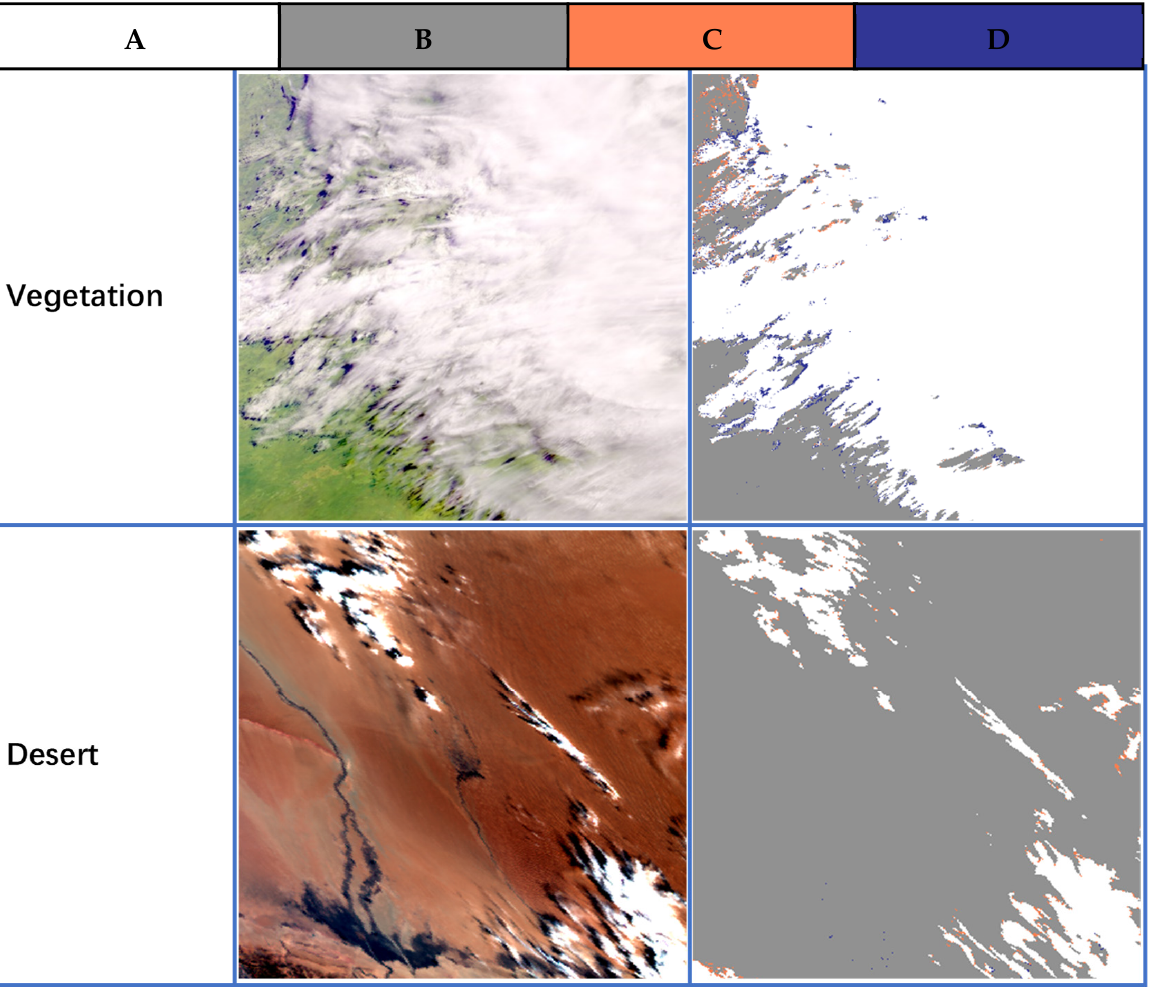
Figure 9. Per-pixel comparison of NNDT cloud identification results (NNDT-CLFG) based on SGLI observation data and SGLI-CLFG. The pixels represent ( A ). NNDT-CLFG and SGLI-CLFG are both cloudy (white), ( B ). both are clear (gray), ( C ). NNDT-CLFG are cloudy and SGLI-CLFG are clear (orange), and ( D ). NNDT-CLFG are clear and SGLI-CLFG are cloudy (blue). Column 1: Composite true-color images of SGLI. Column 2: Per-pixel comparison image for cloud-screening results obtained by NNDT algorithm and SGLI-CLFG. Line 1: Case over vegetation at T0527 26 April 2018 for SGLI. Line 2: Case over desert at T0524 10 March 2018 for